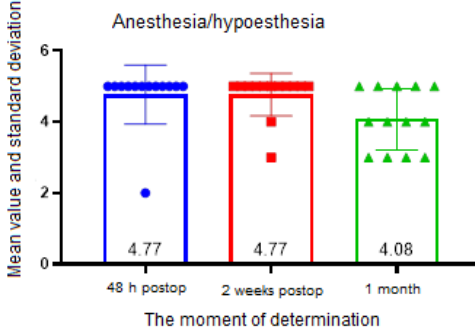
Figure 13. Anesthesia, hypoesthesia assessment.